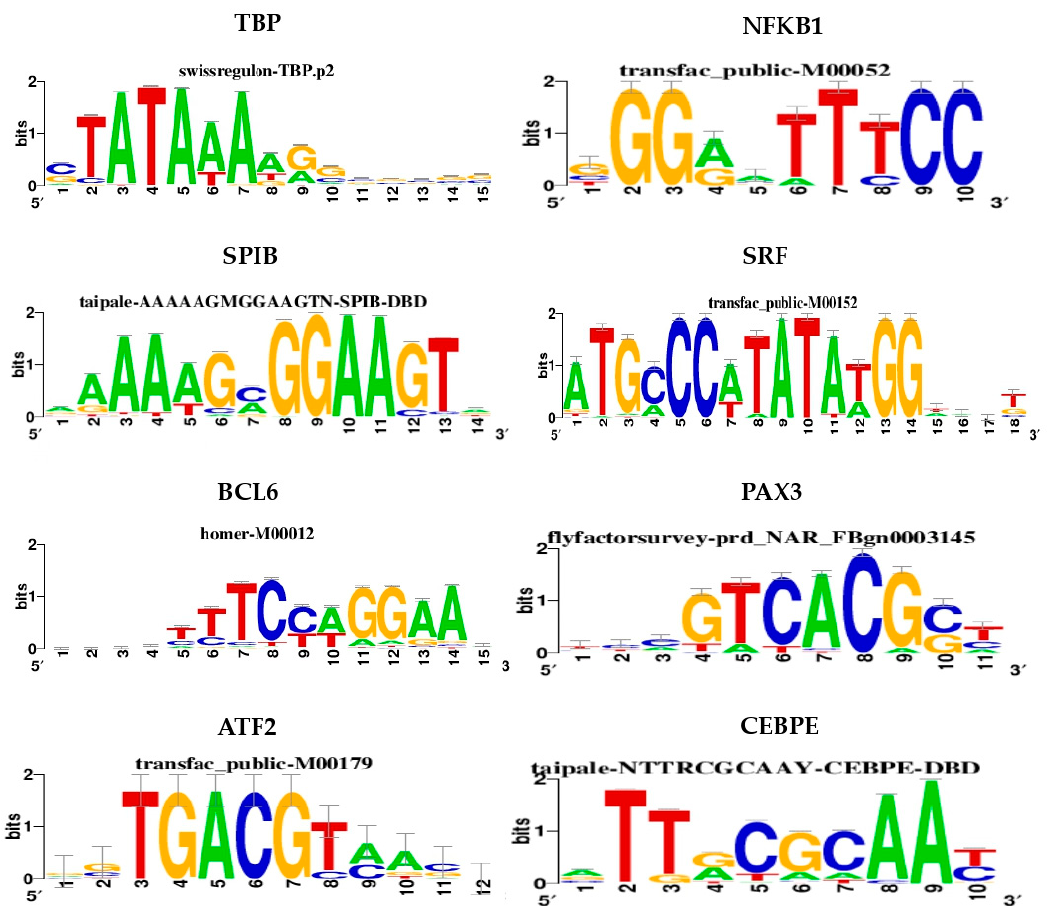
Figure 1. Target nucleotide sequences. Logos of cis-regulatory elements corresponding to the highest enriched motif of each cluster are shown. Motif IDs are reported on top of each sequence. The logo for tracks, i.e., CHD1, is not available.